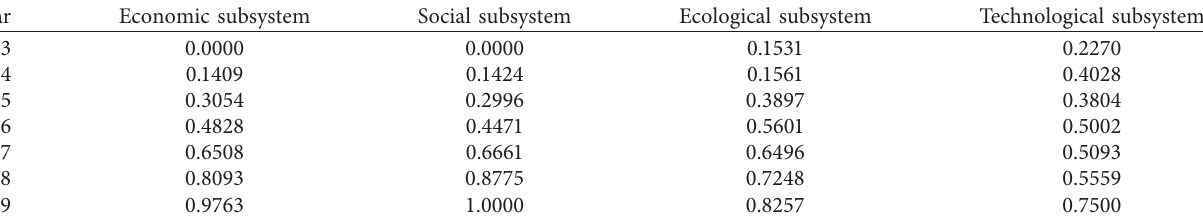
Figure 1: The comprehensive niche value of Beijing-Tianjin-Hebei region. Table 4: Order degree of the Beijing-Tianjin-Hebei regional